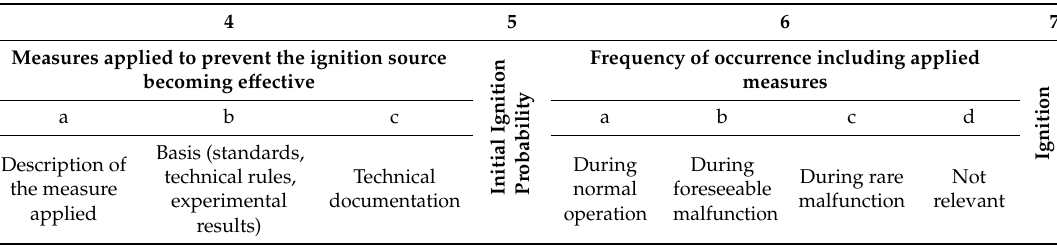
Table 9. Final ignition likelihood